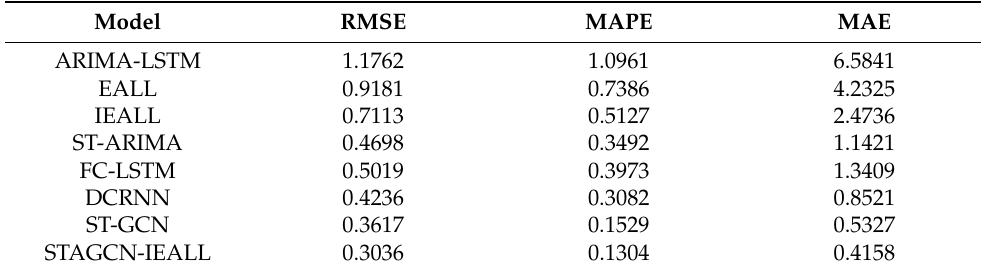
Table 7. Prediction results of different